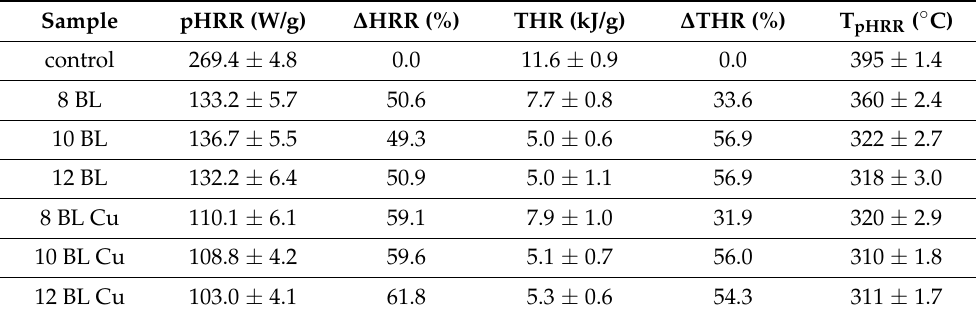
Figure 2. MCC curves for untreated cotton (control) and cotton coated with 8, 10 and 12 BL of PA/CH-urea. Table 3. MCC data of cotton coated with different recipes (with standard deviations).